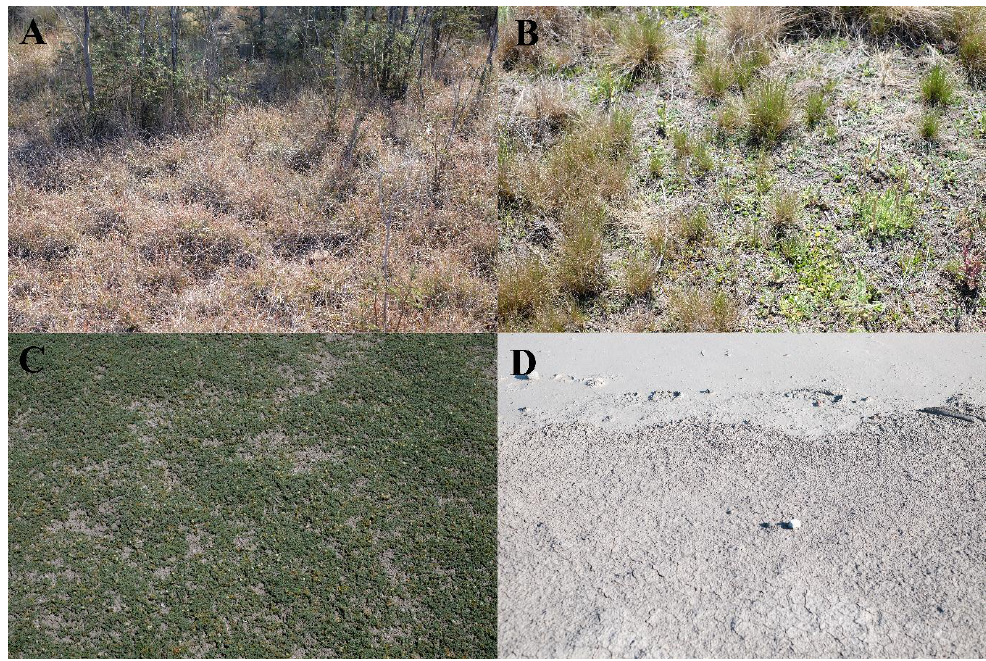
Figure 1. Examples of vegetation communities found in the Tunbridge Township lagoon. From top-left to bottom-right: ( A ) Wilsonia rotundifolia/Selliera radicans ; ( B ) Danthonia/Poa grassland; ( C ) Themeda triandra grassland; and ( D ) Saltpan.